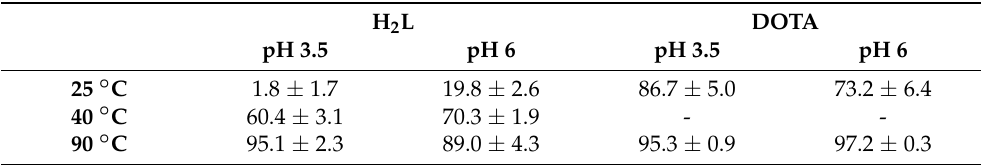
Table 5. The radiochemical yields for the reaction of 68 Ga 3+ with H 2 L (50 µ M) and DOTA (50 µ M) at pH 3.5 and pH 6 and various temperatures (25, 40 and 90 ◦ C)